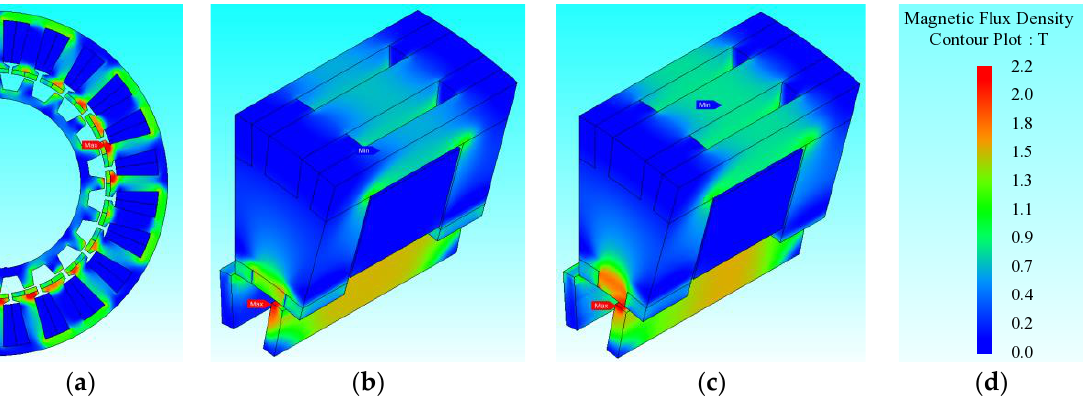
Figure 7. Magnetic-density distribution of motor under rated load: ( a ) 24 stator slots − 20 rotor poles FRM, ( b ) TF − FRM, ( c ) TF − CFRM, and ( d ) reference ruler.